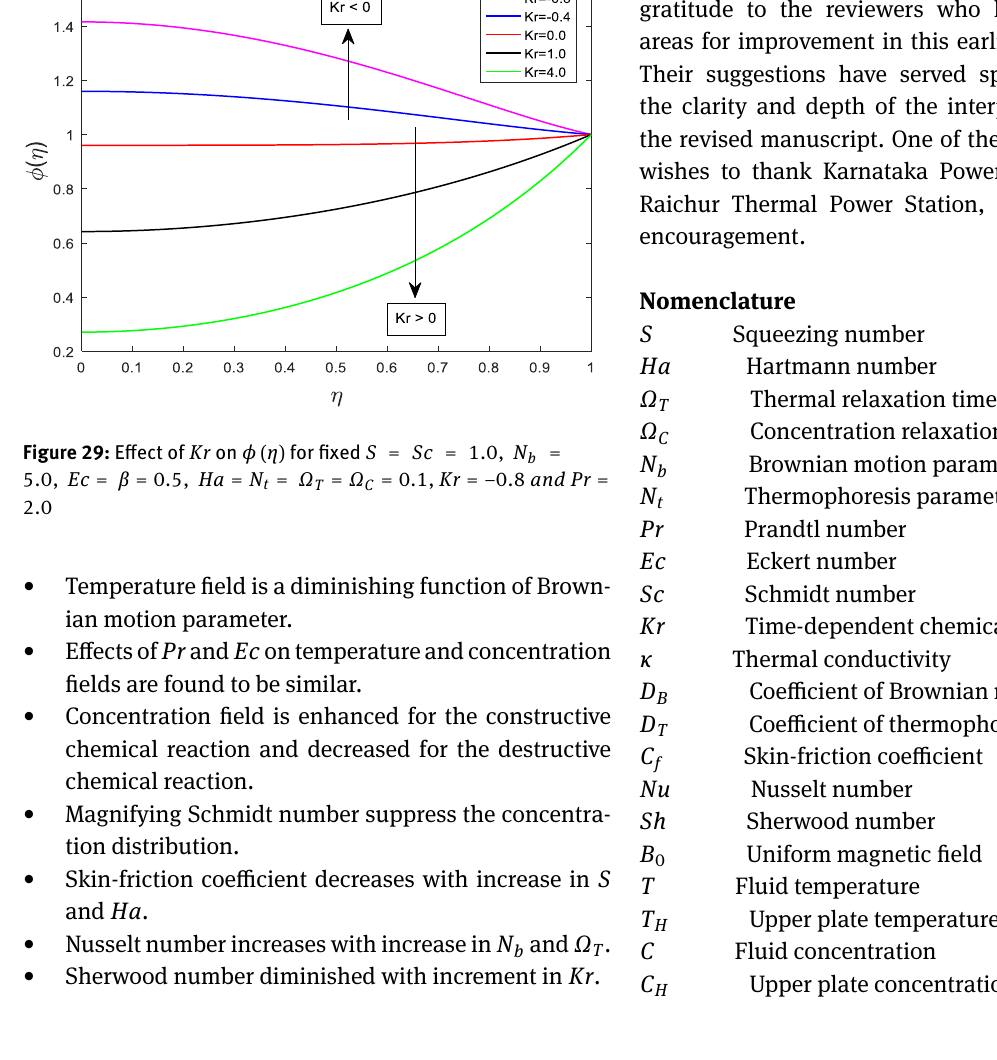
= Ω = Ω = 0.1, Kr = −0.8 and Pr = t T C